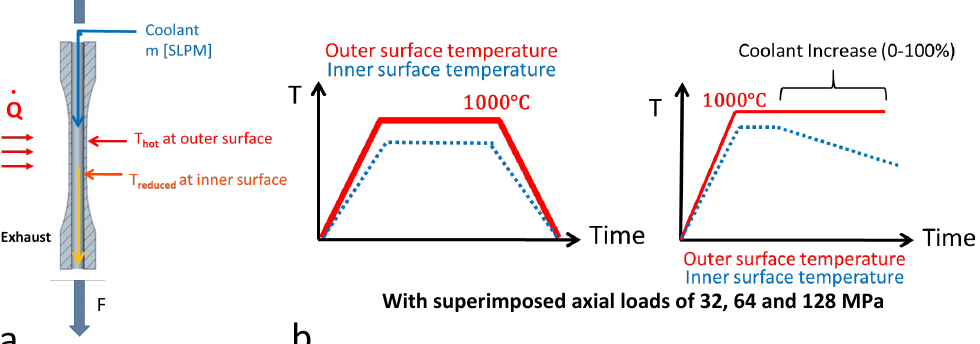
Figure A1. Experimental setup: ( a ) application of mechanical loading; and ( b ) thermal loading profiles for cycle testing and flow testing [23–25].